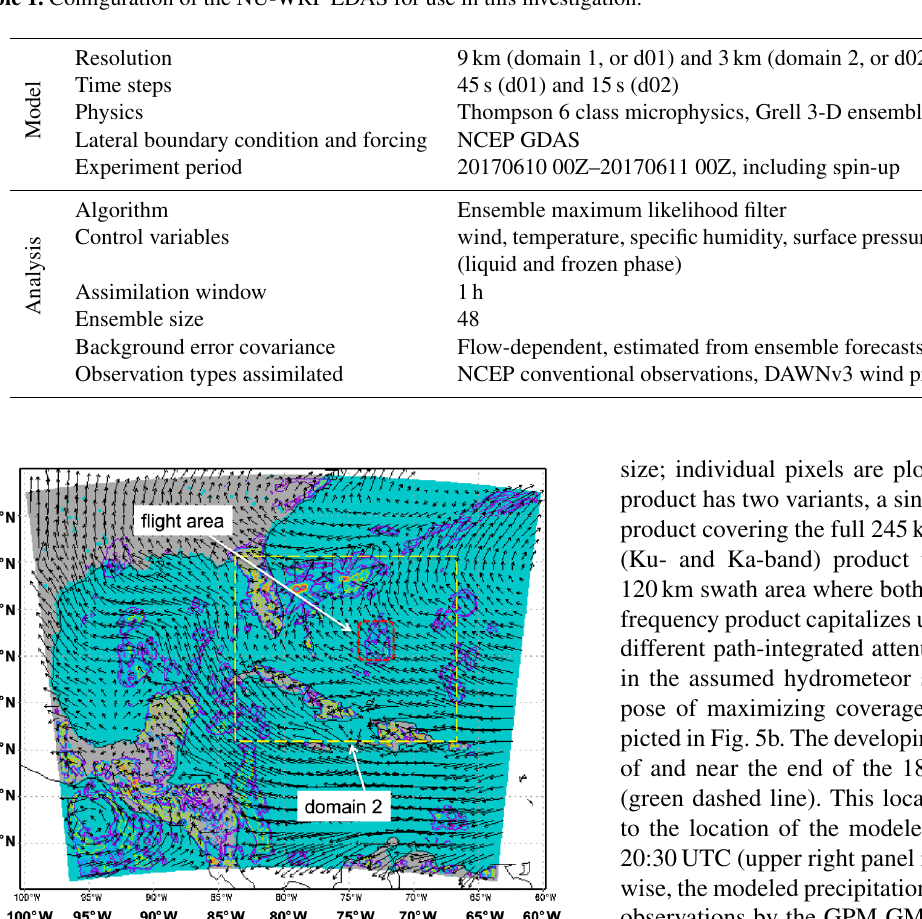
Table 1. Configuration of the NU-WRF EDAS for use in this investigation.